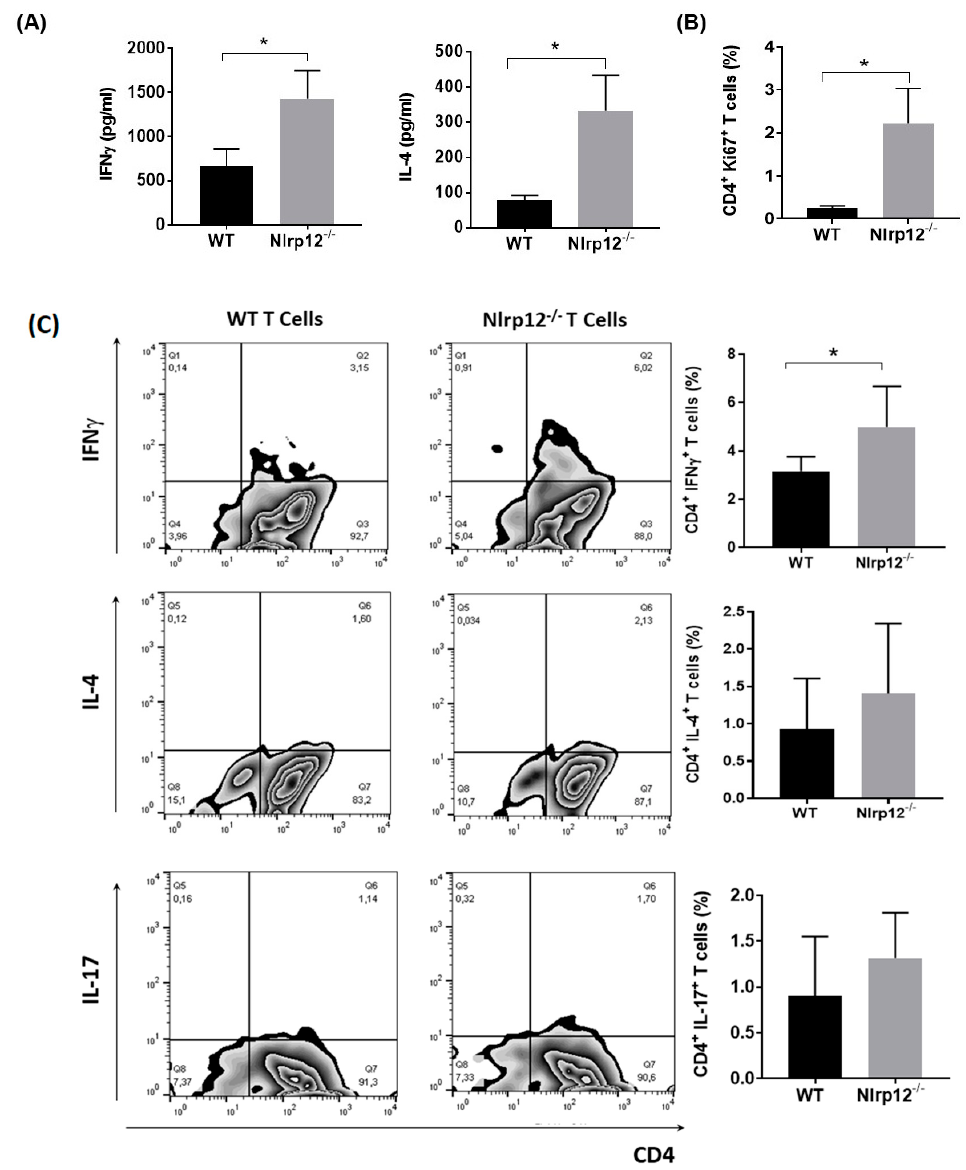
Figure 2. Nlrp12 inhibits T cell proliferation and cytokine production by CD4 + T cells . ( A ) Purified CD4 + T cells from WT and Nlrp12 − / − mice were stimulated with anti-CD3/CD28 for 72 h. Cell culture supernatants were collected and the levels of IFN γ and IL-4 were measured by ELISA, n = 4; ( B ) Purified CD4 + T cells from WT and Nlrp12 − / − mice were stimulated with anti-CD3/CD28 for 24 h and the proliferation of CD4 + T cells was evaluated using Ki67 staining and flow cytometry; ( C ) CD4 + T cells were activated with anti-CD3/CD28 for 48 h and the expression of intracellular cytokines was measured using flow cytometry. Representative flow cytometric plots show the expression of IFN γ , IL-4 and IL-17 in CD4 + T cells, n = 4; * p < 0.05.